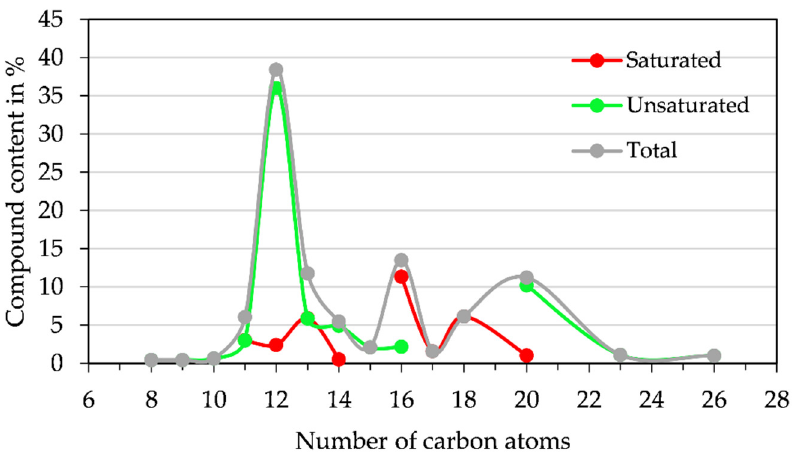
Figure 6. Percentage of compounds in (PP + 1% 2 ‐ EHN) pyrolysis oil and their carbon number (total compound content—grey, saturated compound content—red, unsaturated compound content— green).